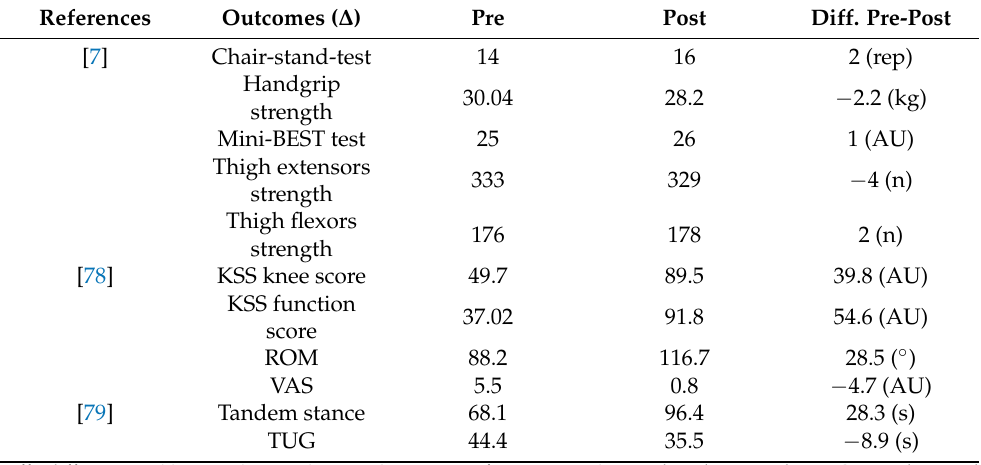
Table 6. The main outcomes during